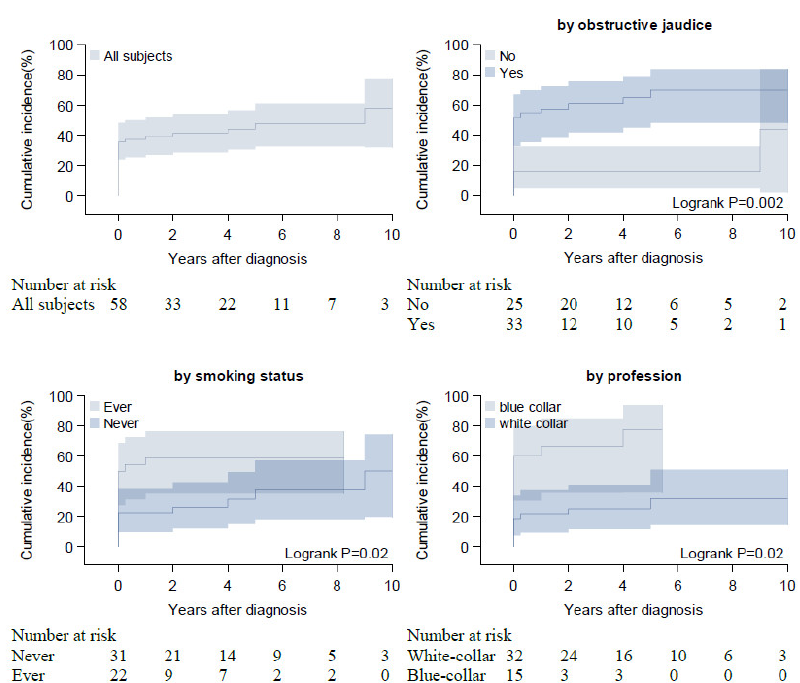
Figure 2. Prevalence of DM at diagnosis of AIP and cumulative incidence during the follow-up (stratified by obstructive jaundice, profession, and smoking status). Smoking status missing for 5 patients, profession for 11 patients; Analysis is restricted to 58 patients with available information about DM at diagnosis.